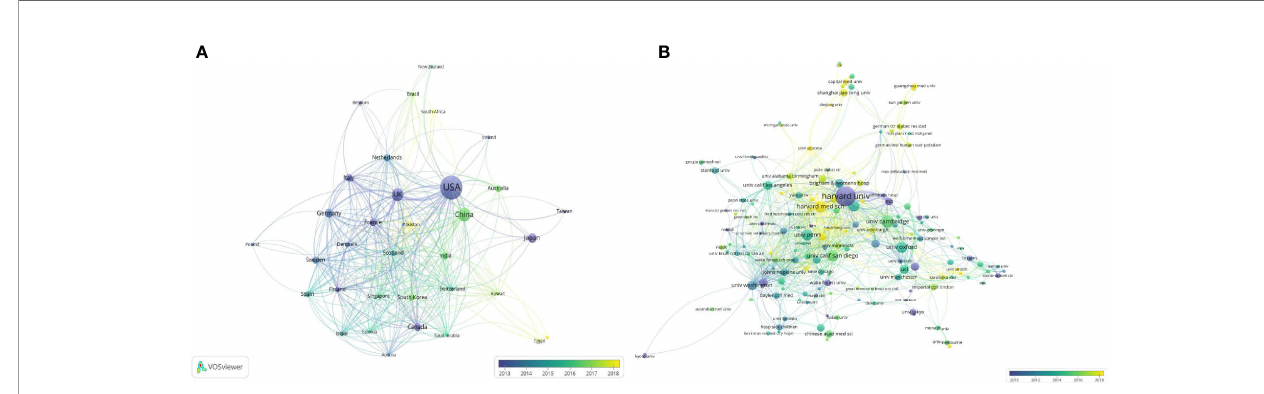
FIGURE 2 | (A) The network of cooperation between countries/regions. (B) The network of cooperation between institutions based on VOSviewer. Node size indicates the number of publications; the link size refers to the cooperation Intensity; the earlier contributions were presented in darker